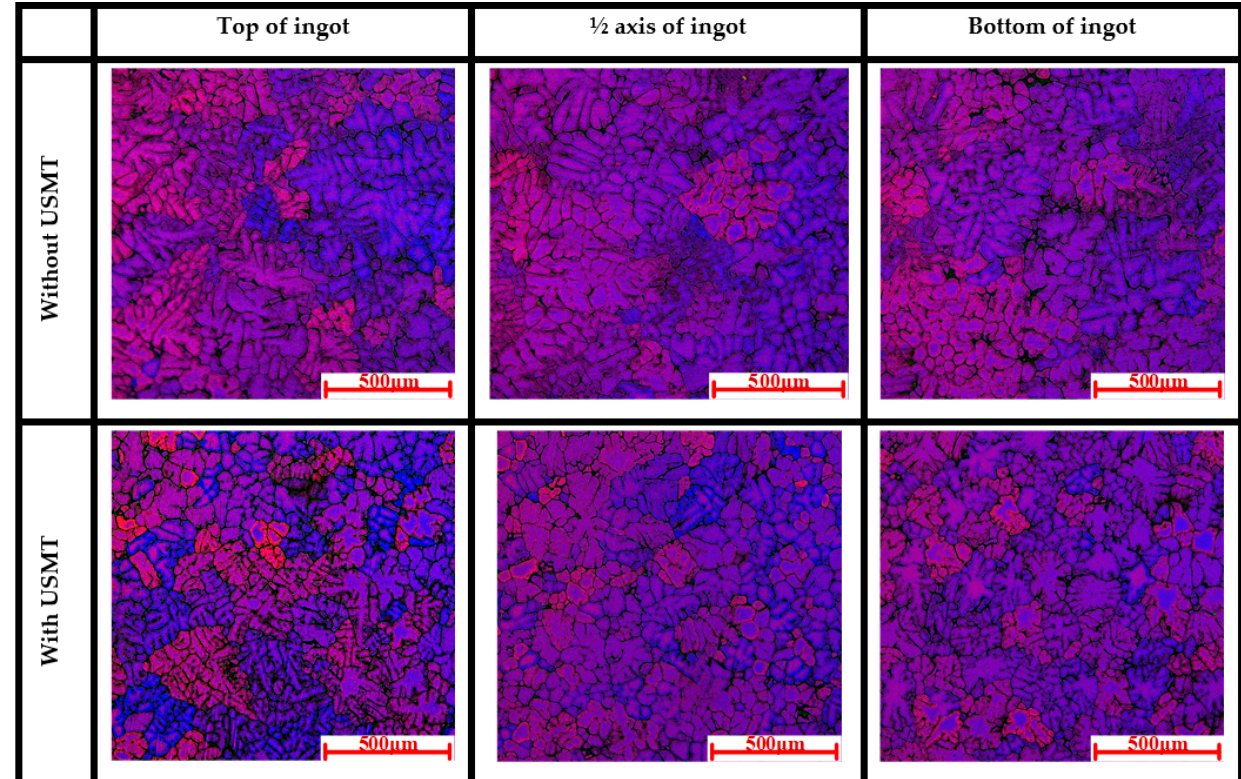
Figure 3. Optical micrographs at specific sampling positions in ingots formed with and without USMT.